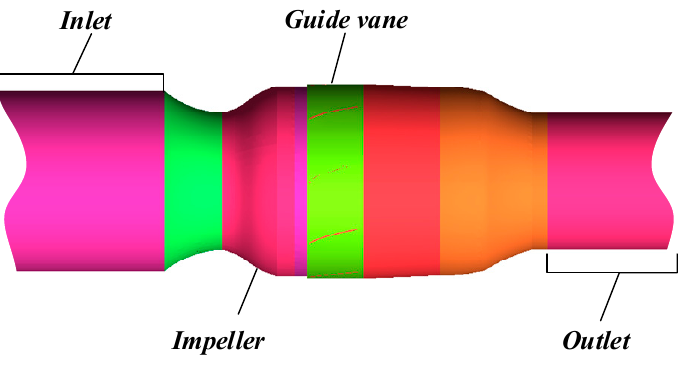
Figure 4. The calculation domain division.